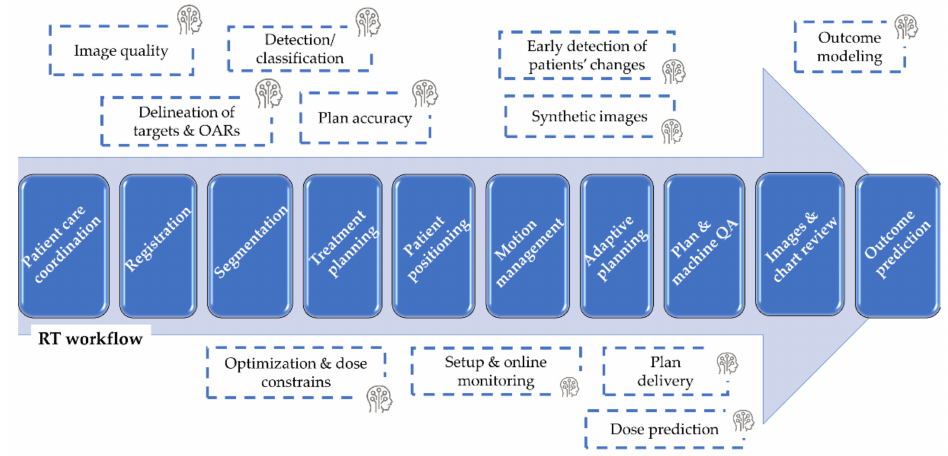
Figure 1. Steps of the RT patient-based workflow, in which AI-based techniques can be applied.